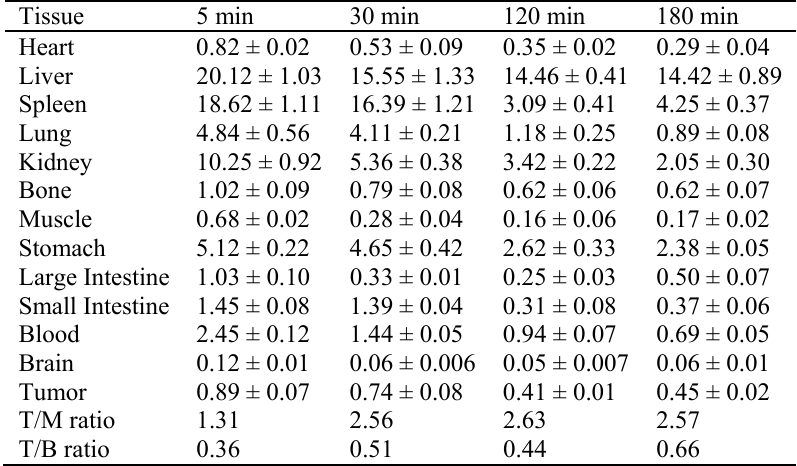
Table 3. Biodistribution of 99m TcN-MAF-ABCPP in mice bearing S 180 tumor (%ID/g) b .